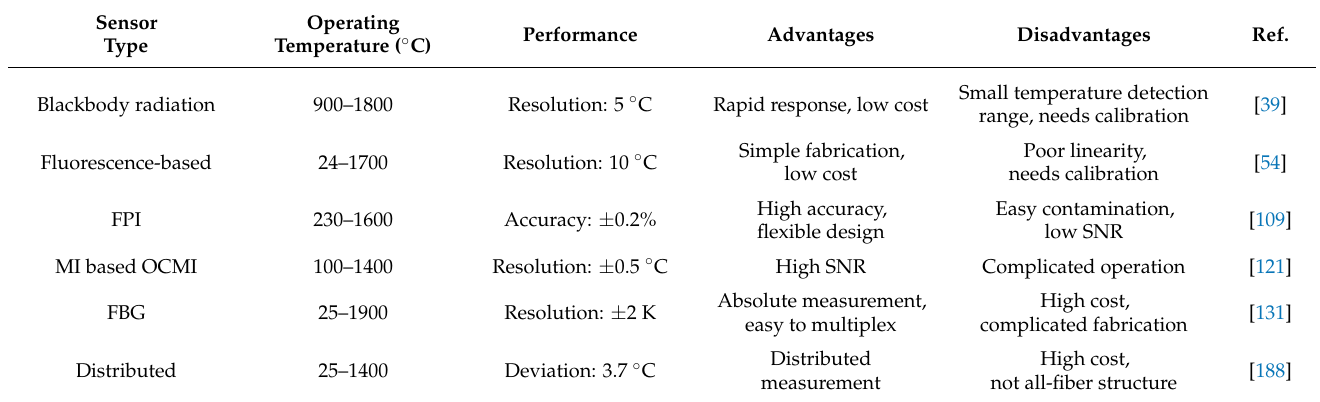
Table 8. Summary of single-crystal optical fiber sensors for high-temperature